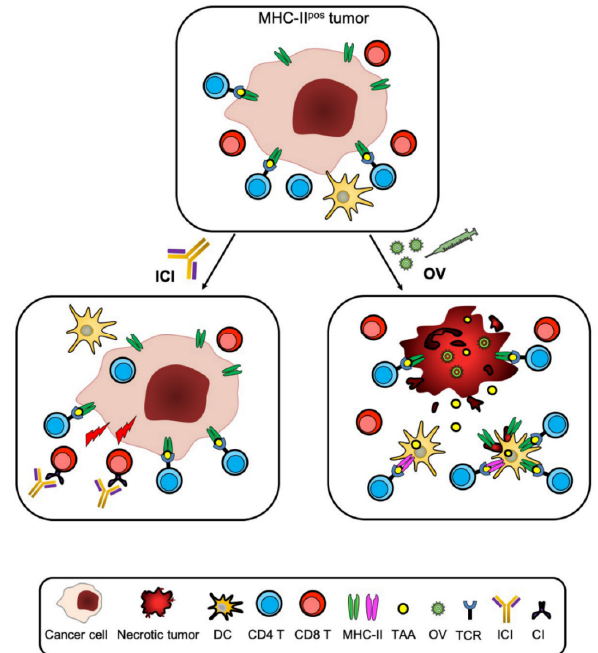
Figure 3. Increasing the breath and efficacy of anti-tumor immunotherapy by combined approaches . CIITA-driven MHC-II expression in tumor cells can be combined to additional immunotherapeutic strategies to increase tumor antigen recognition and effector cell activation. For example, CD4+ Th cells triggered by MHC-II+ tumor cells can activate anti-tumor CTL and synergize with inhibitory anti-immune checkpoint mAbs (ICI) in rescuing exhausted anti-tumor CTL, thus potently increasing both the number and cytotoxic activity of CTL. Furthermore, tumor antigen availability generated by CIITA-driven MHC-II expressing tumor cells can be increased by the action of oncolytic viruses (OV) that upon killing of the tumor cells will liberate additional antigenic material either free or under the form of MHC-II-peptide complexes derived from CIITA-expressing tumor cells. The combined antigen-presenting cell (APC) function of MHC-II-expressing cells and classical professional APCs infiltrating the tumor will increase the capacity of tumor-specific CD4 + Th cells to recognize tumor antigens and initiate the cascade of events leading to e ff ective anti-tumor